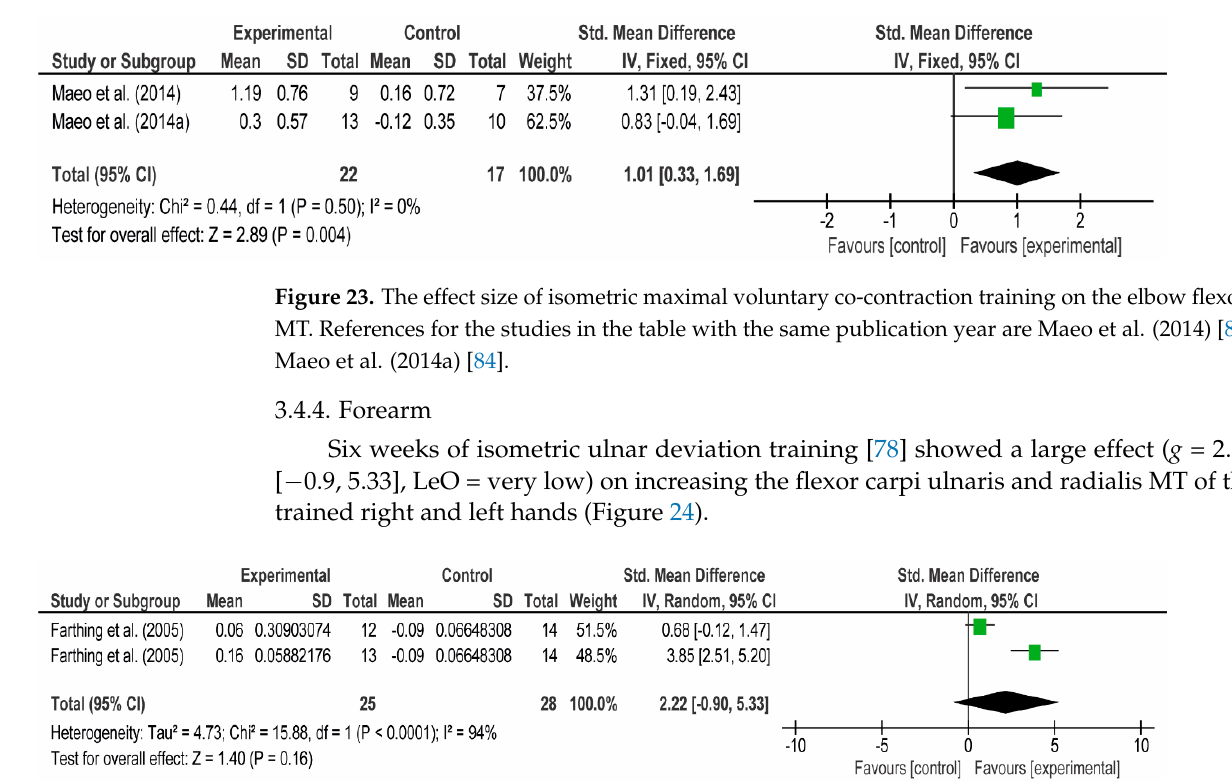
lines respectively represent 50%, 60% and 70% measurement levels of elbow flexors’ MT.